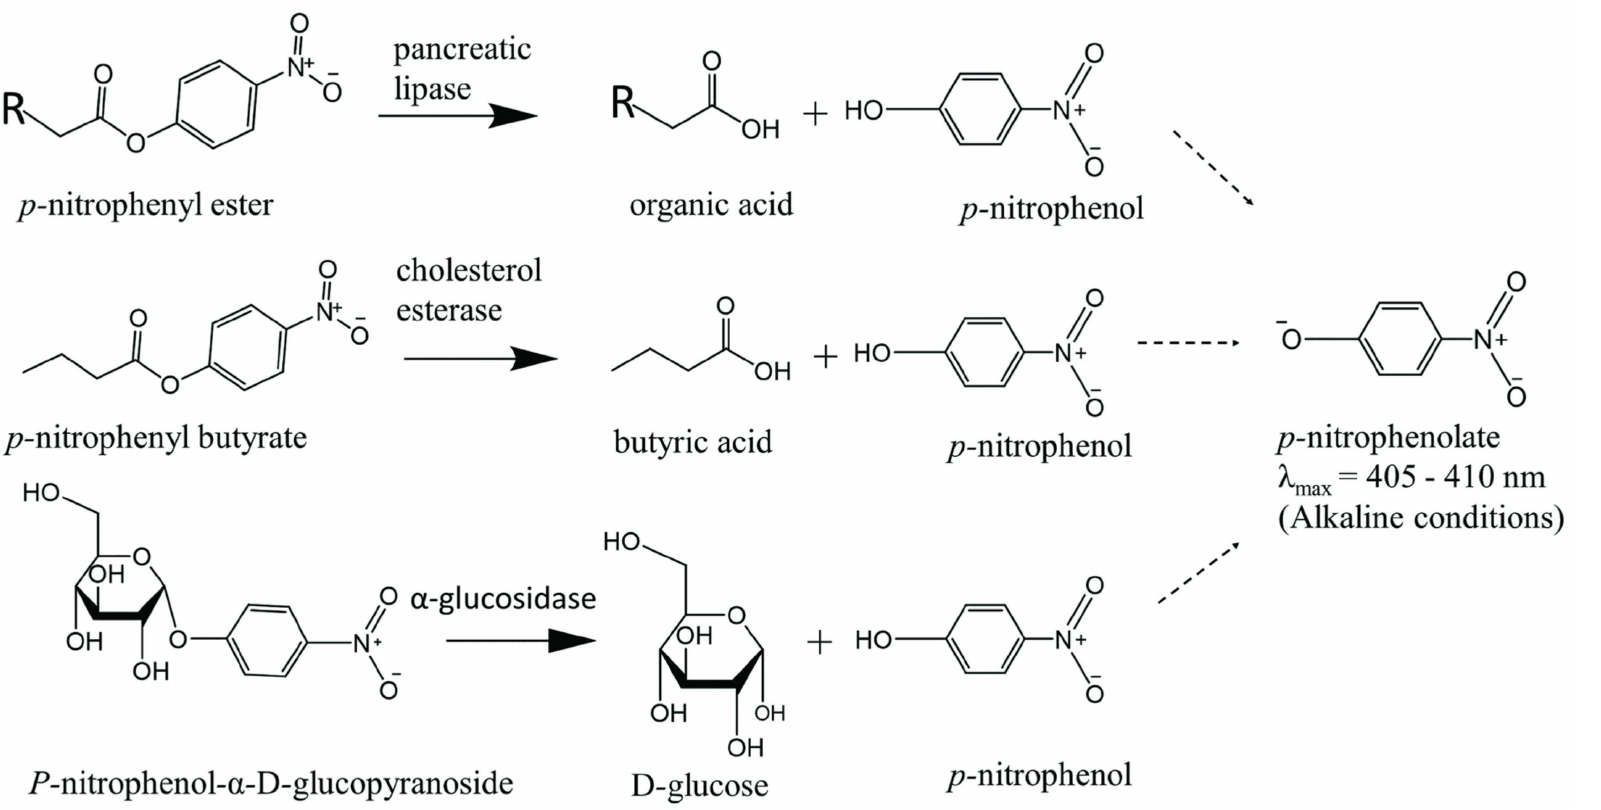
Figure 1. Common enzymatic reactions used to screen medicinal plants for inhibitors of pancreatic lipase, cholesterol esterase, and α -glucosidase. All these reactions lead to the formation of p -nitrophenol as one of the products. p -nitrophenol will be converted to yellow color p -nitrophenolate under alkaline conditions. The figure was generated using ChemDraw Professional